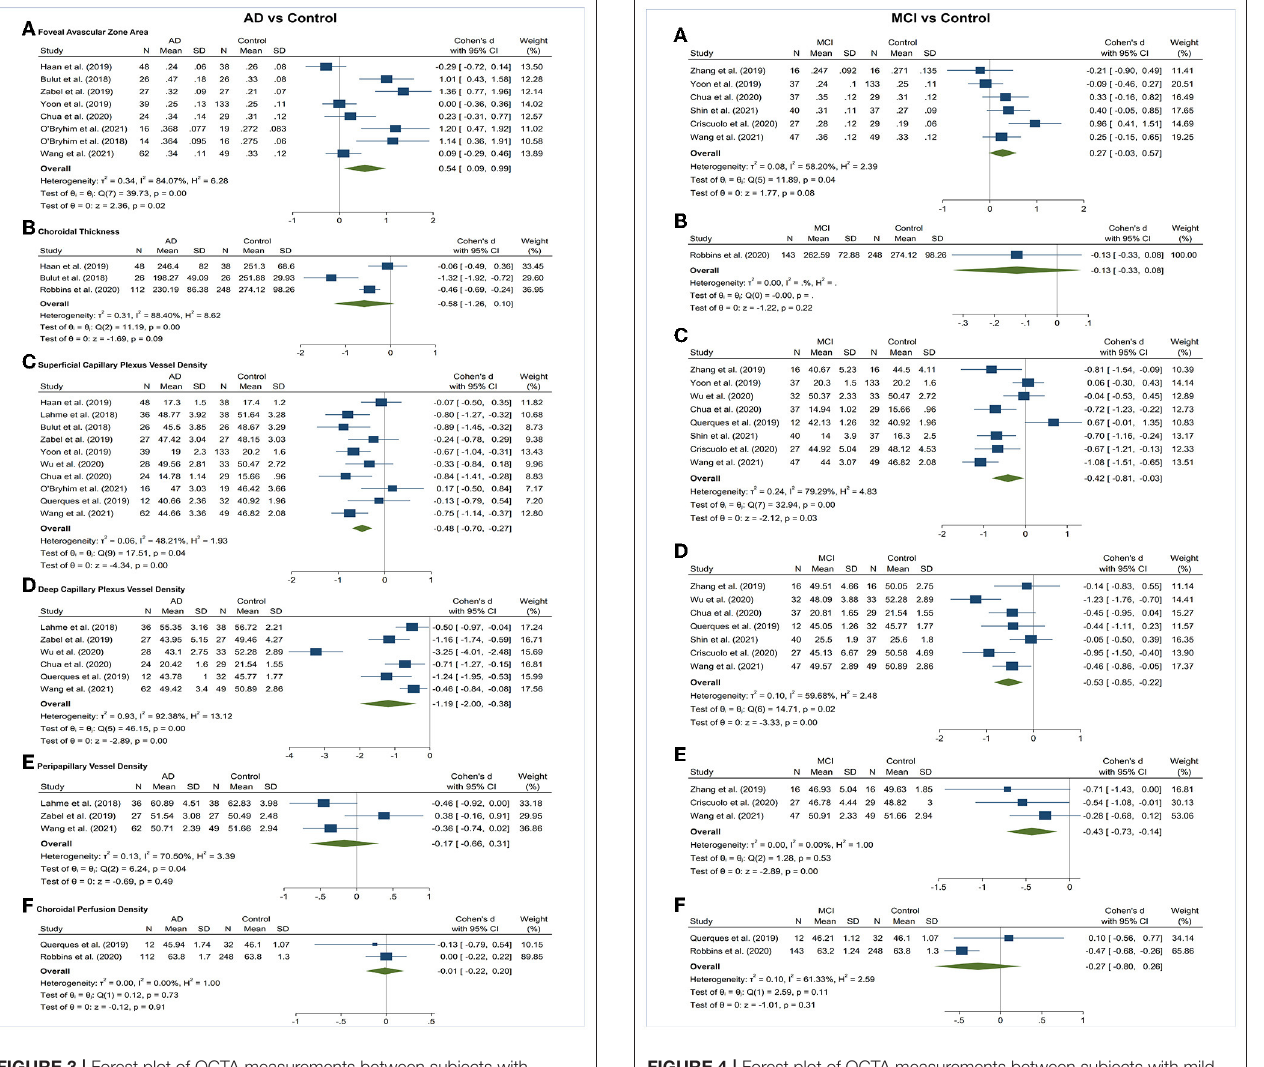
FIGURE 3 | Forest plot of OCTA measurements between subjects with Alzheimer’s Disease (AD) and healthy controls. The meta-analyses were conducted with a random-effects model. Horizontal bar indicates 95% confidence intervals (CI), and the size of the squares denotes the weight attributed to each article. The diamonds represent the standardized mean differences with the width showing the 95% CI. (A) Foveal avascular zone area. (B) Choroidal thickness. (C) Superficial capillary plexus vessel density. (D) Deep capillary plexus vessel density. (E) Peripapillary vessel density. (F) Choroidal perfusion density.